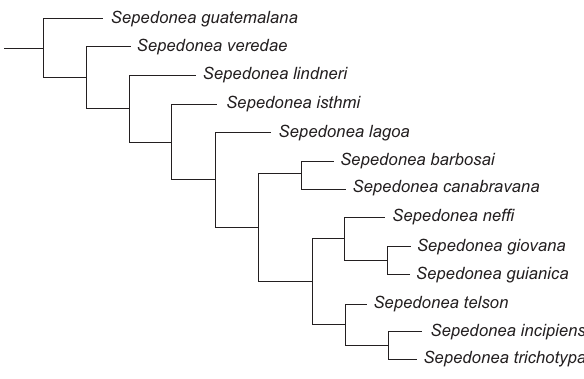
Figure 1. Phylogenetic analysis for the Sepedonea species (modi- fied from M ARINONI & M ATHIS